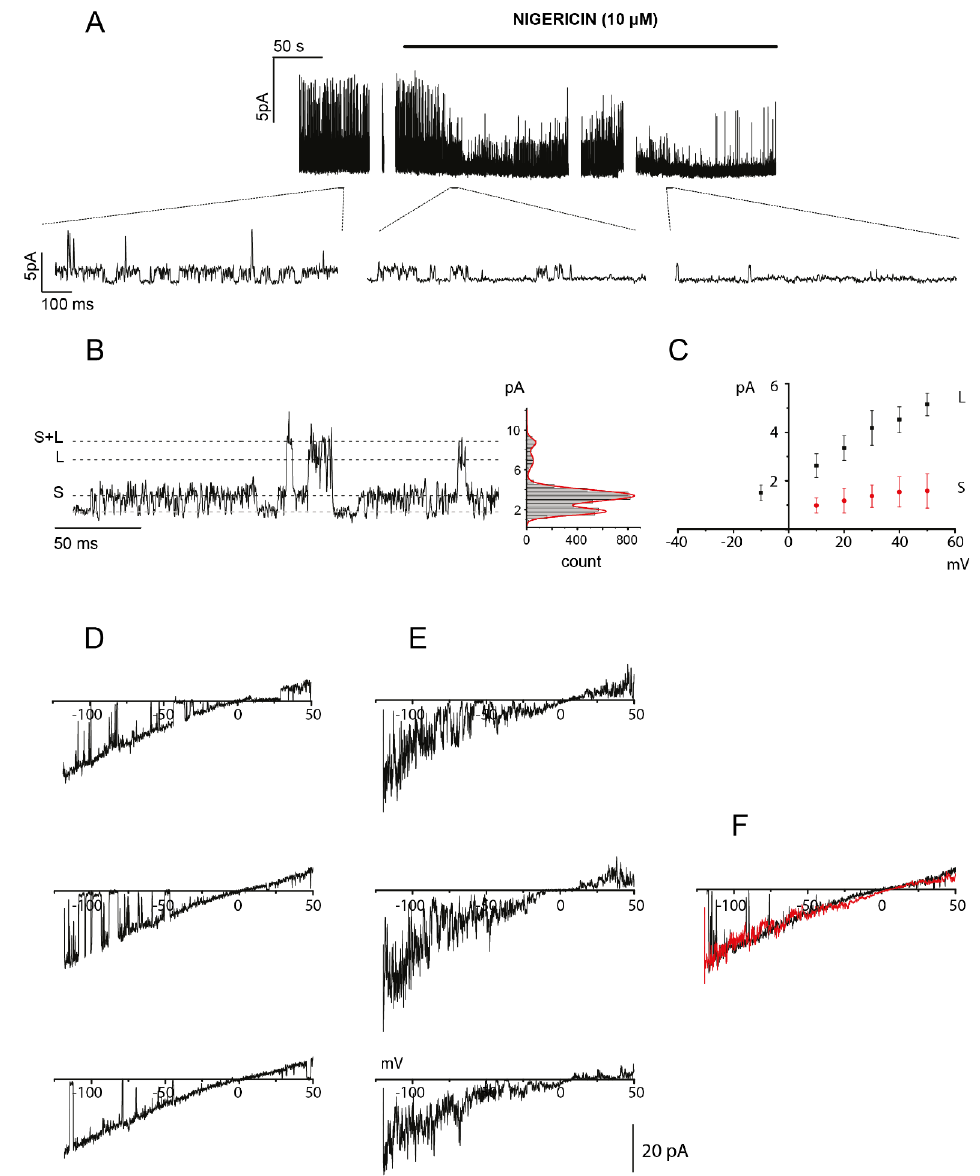
Figure 3. Oxaliplatin-dependent cytosolic acidification modulates TREK-2 channel activity. ( A ) Single-channel recording at V hold = + 40 mV from an OHP treated DRG neuron, before and during nigericin perfusion. When nigericin sets the pH at physiological levels, TREK-2 channel activity strongly decreased. Insets show a magnification in three di ff erent time recording points (2 min before nigericin perfusion; 1 and 4 min after nigericin perfusion, respectively). ( B ) An exemplary single-channel current trace recorded in cell-attached configuration at V hold = + 40 mV from an OHP treated DRG neuron and the corresponding amplitude histogram. Two di ff erent levels of current could be observed: the smaller one (S) and the larger one (L). ( C ) I-V plot for the channel levels S and L shown in ( B ). ( D ) Single-channel currents recorded during voltage ramps in an OHP-treated neuron in a cell-attached patch with high potassium solution in the pipette. ( E ) Exemplary single-channel current trace recorded in an inside-out configuration during the stimulation with arachidonic acid (2 µ M) in symmetrical K + solutions. ( F ) Merge of the average of 10 current ramps recorded in the presence of arachidonic acid (red trace) with a single-channel ramp curve (black trace) taken from the same sample of the traces shown in ( D ).